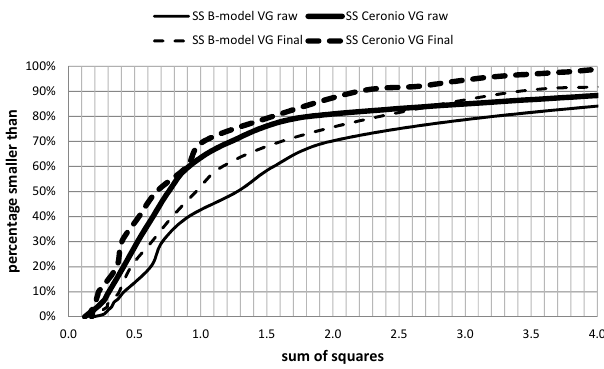
Figure 3. Cumulative sum of square for the VG treatment plant.